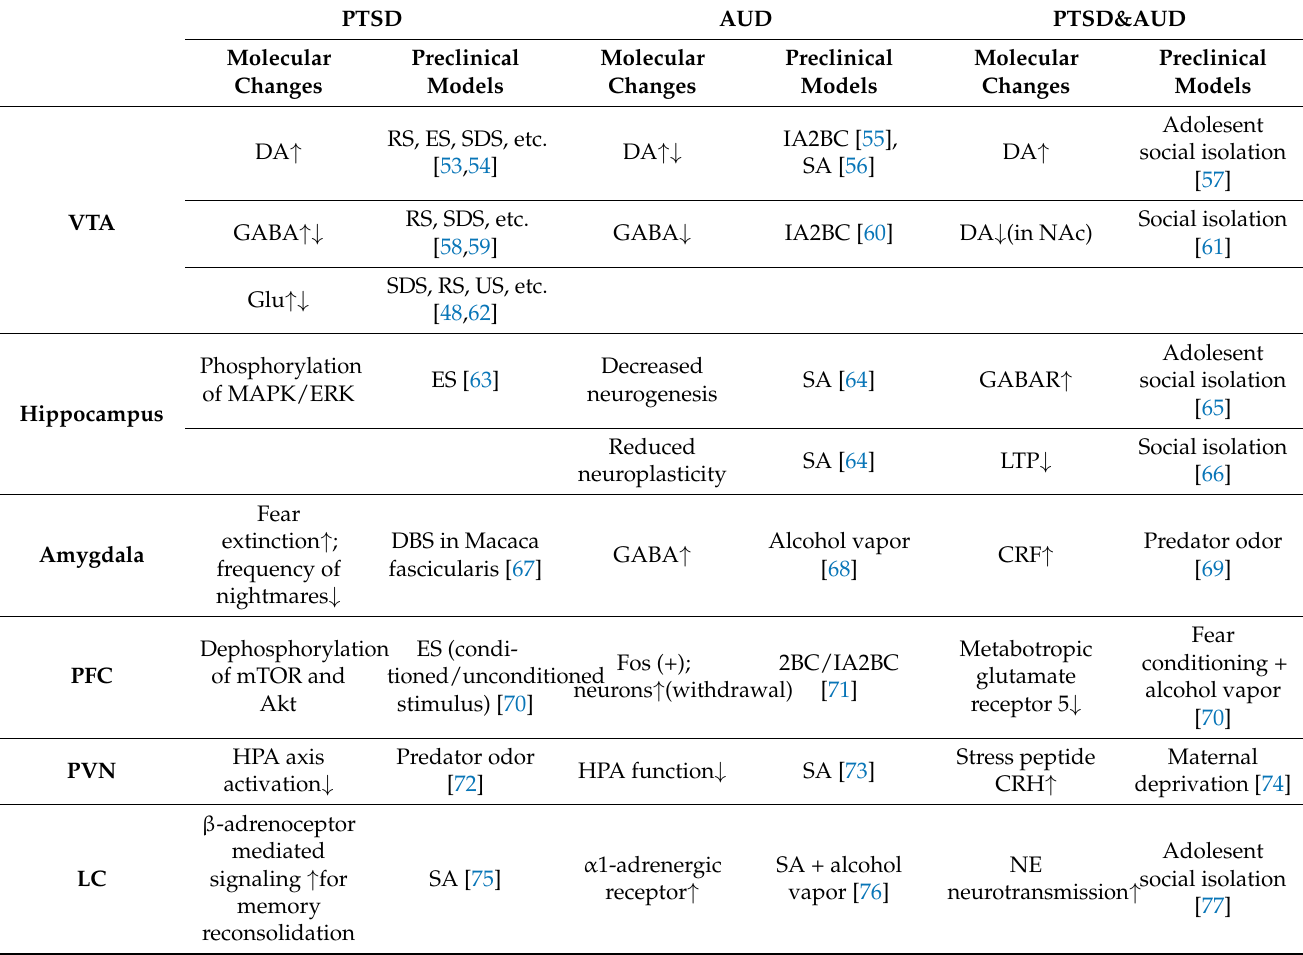
Table 4. Preclinical models and circuitry of PTSD or/and